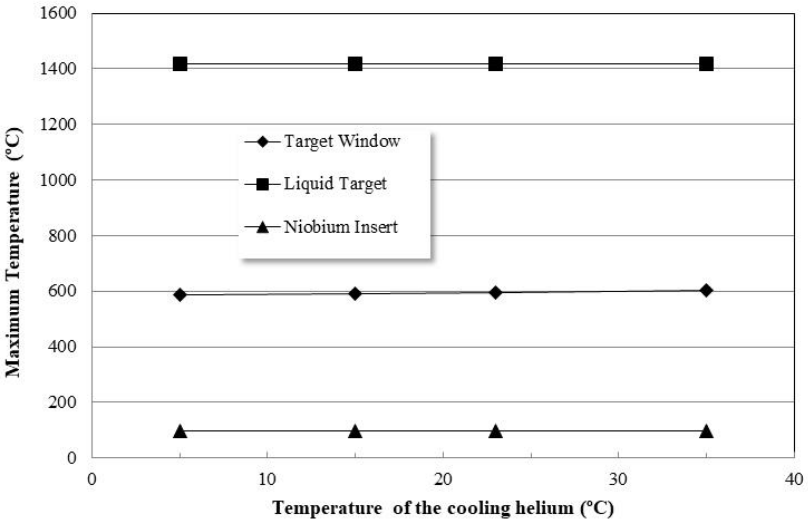
Figure 18. Maximum temperatures of the target window, liquid target, and niobium insert as a function of the initial temperature of the cooling helium.